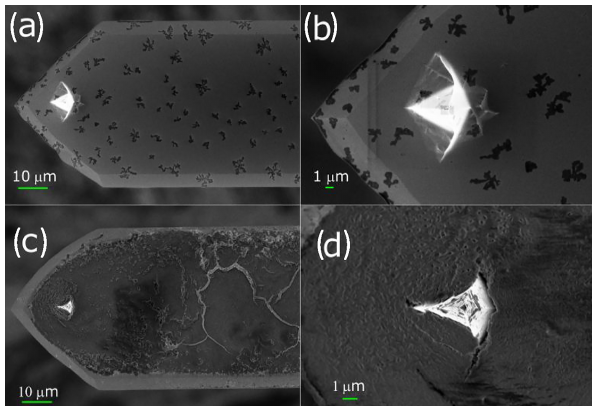
Table 3. EDS analysis of the Pt/Ir (PIC) tips, before and after usage.